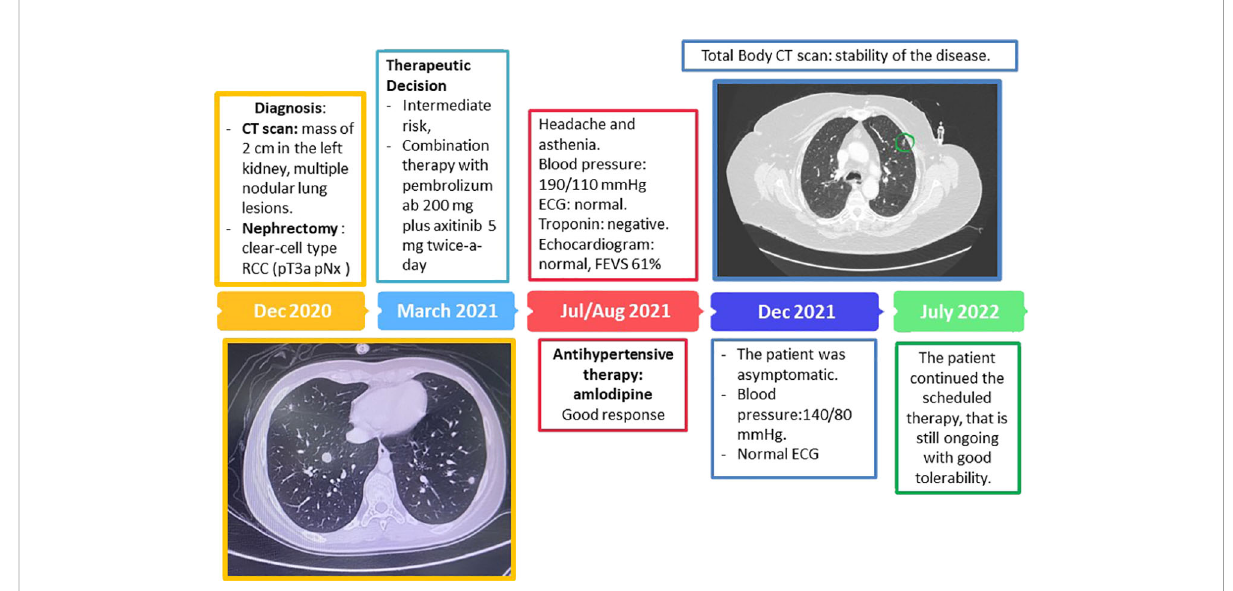
FIGURE 5 Timeline management of cutaneous toxicity in the course of cabozantinib